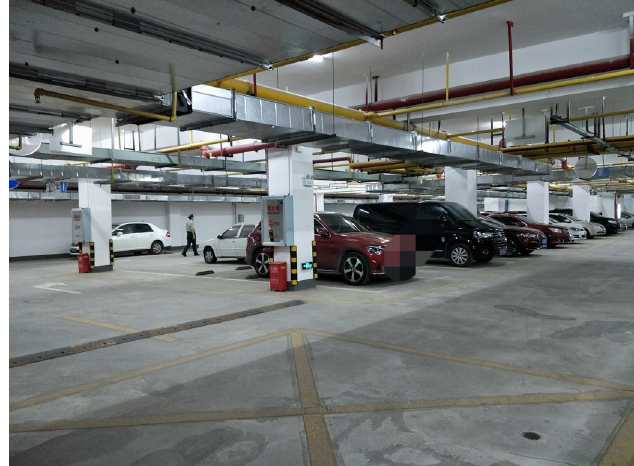
Figure 4. Experimental site local environment.